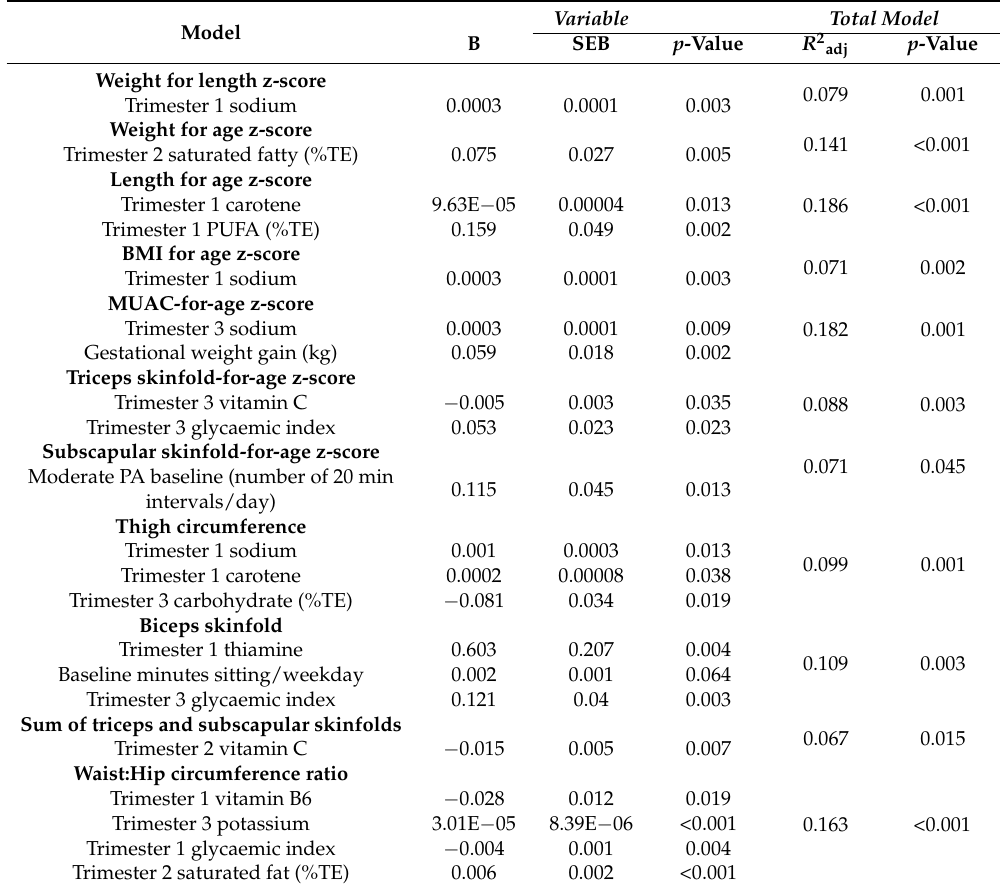
Table 3. Maternal and paternal characteristics and maternal nutrient intakes associated with 6 months old offspring adiposity-adjusted analysis